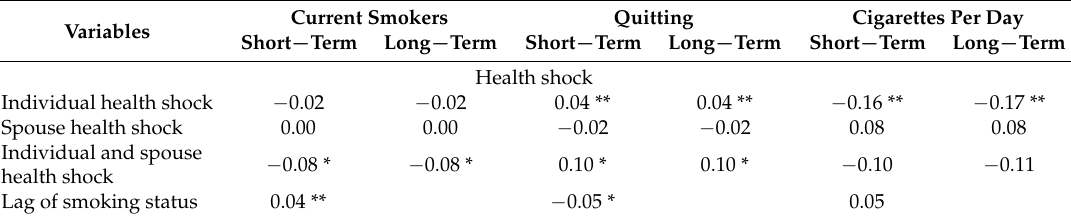
Table 4. Long-term marginal effects of health shocks on smoking behaviors with IDL model.